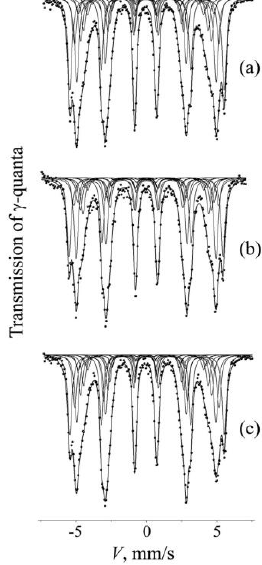
Figure 3. Spectra for the alloy Fe 90.6 Cr 9.4 . Treatment (state): ( a ) annealed at 1073 K (as-received); ( b ) as-received and irradiated with (fluence of) F = 2 × 10 22 m −2 at 420 K; ( c ) as-received and HPT (ε = 5.9, n = 3 rev.) at 573 K. Individual subspectra S ( N 1 , N 2 ) corresponding to atomic configurations taken into account are indicated.